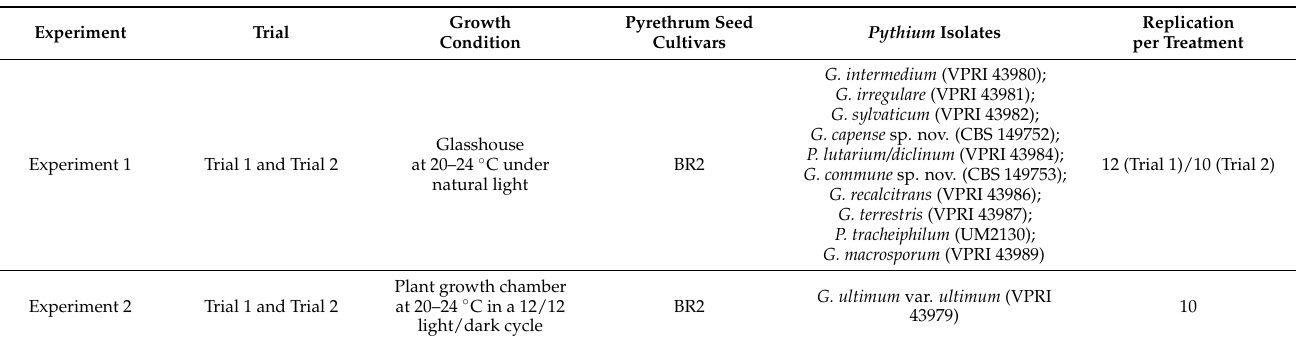
Table 6. Glasshouse post-germination bioassay investigating pathogenicity of Globisporangium and Pythium spp. on